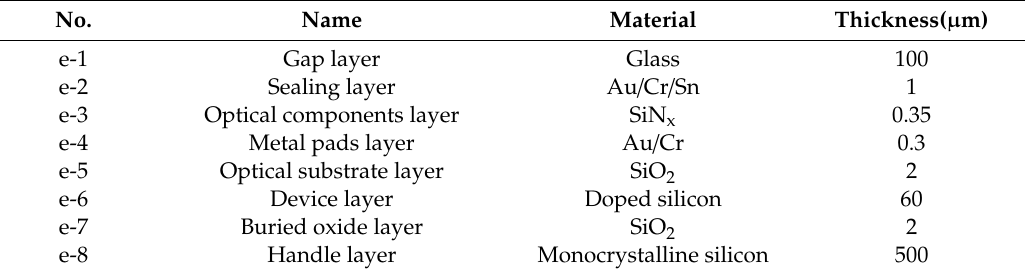
Figure 1. Diagrams of the structure of the micro-opto-electro-mechanical (MOEMS) gyroscope: ( a ) Diagram of the entire gyroscope; ( b ) Exploded view; ( c , d ) Partial enlarged drawing; ( e ) Cutaway drawing. Table 1. Information about each layer in Figure 1e.